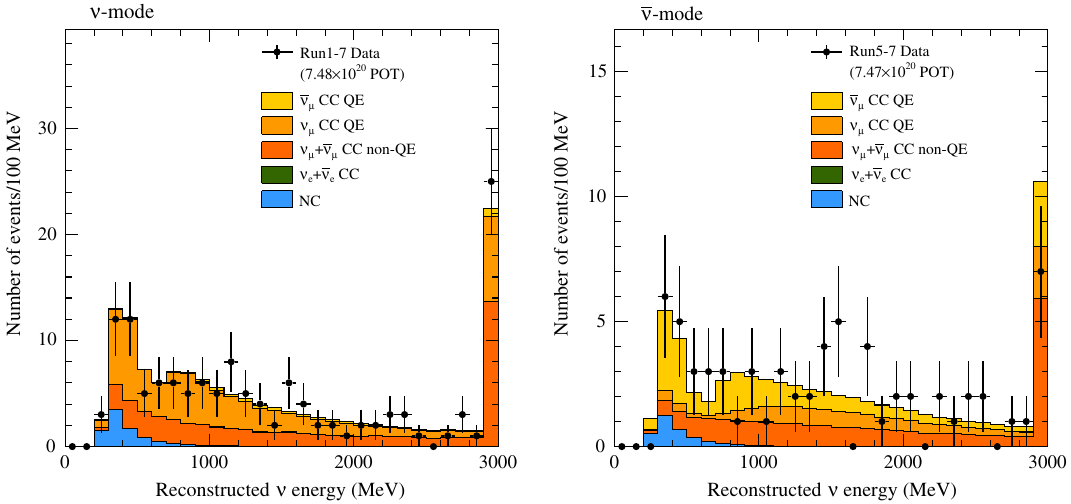
Fig. 68 Reconstructed neutrino energy distributions of muon neutrino eventsinneutrinobeammode(left)andanti-neutrinobeammode(right) assuming CC QE interaction kinematics. The data are shown as points